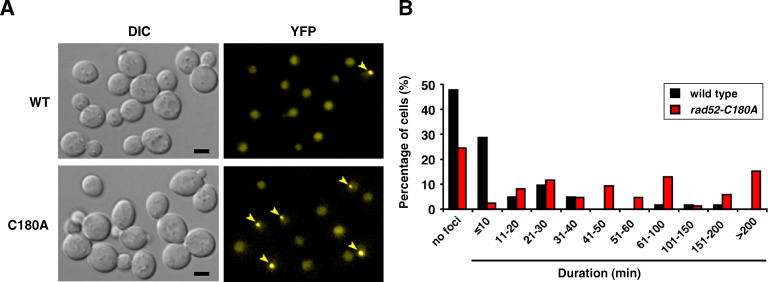
Duration of Spontaneous Rad52-YFP and Rad52-C180A-YFP Foci(A) Rad52-YFP and Rad52-C180A-YFP foci are formed in small-budded cells in mitotically growing cultures. Arrowheads point to Rad52-YFP foci. Scale bar, 3 μm.(B) The percentage of cells that do not develop a Rad52 focus during a cell cycle is shown in the left side of the histogram. The percentage of cells that do form a Rad52 focus is shown in the right side of the histogram as a distribution arranged according to the duration of the Rad52 focus observed in individual cells. Each column represents the percentage of cells that have turned the Rad52 focus over in the time frame indicated. Results from RAD52 and rad52-C180A strains are shown as indicated. Median duration of Rad52 foci is 8 min for the wild-type and 57 min for rad52-C180A.